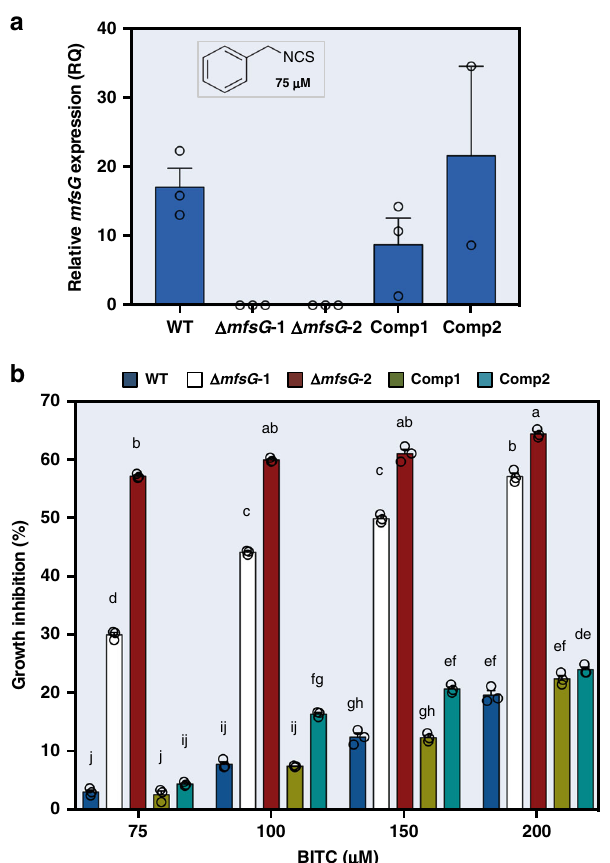
Fig. 2 Characterization of Δ mfsG mutants and complemented mutants. a Expression analysis of mutants and complemented mutants 72 h after exposure to 75 μ M BITC, n = 3. b In vitro growth inhibition 72 h after exposure to different concentrations of BITC. Growth inhibition was calculated as percentage of colony diameter of wild-type (WT) B. cinerea grown on PDA with no ITCs. Data are displayed as mean values (± SE). Different letters above the columns indicate signi fi cant difference at P < 0.05, as determined by Kruskal – Wallis test, n = 3. Source data are provided